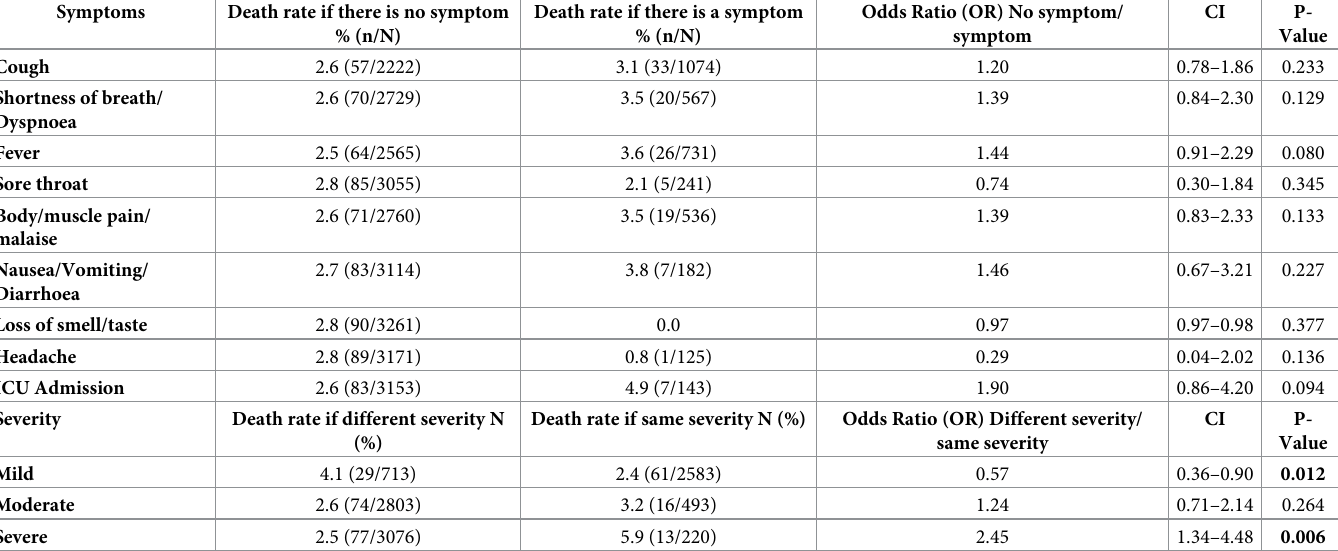
Table 5. Impact of COVID-19 symptoms on mortality following COVID-19 infection.